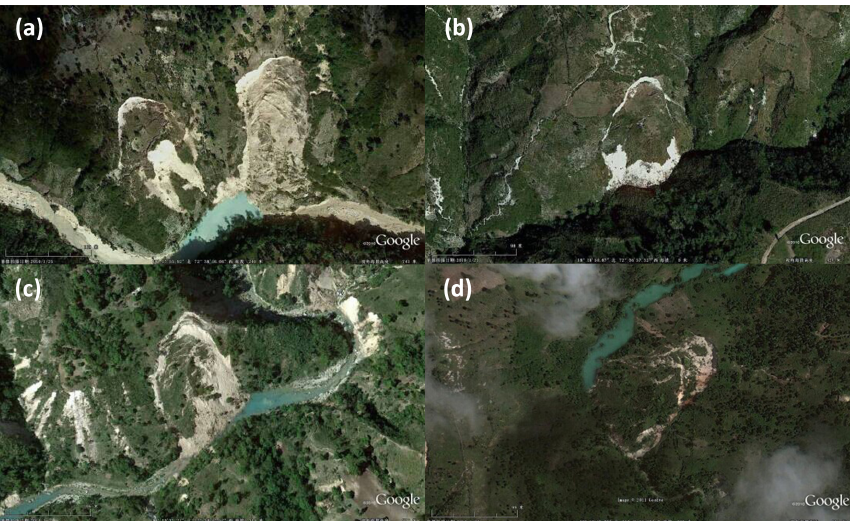
Figure 6. Several typical co-seismic coherent deep-seated landslides. (a) two coherent deep-seated landslides (18 ◦ 17 0 54.15 00 N, 72 ◦ 38 0 18.95 00 W) within a short distance; the image is taken on 25 January 2010 (upward is north). (b) is located at 18 ◦ 18 0 50.87 00 N, 72 ◦ 36 0 57.32 00 W, and the image was taken on 25 January 2010 (upward is north). (c) is located at 18 ◦ 19 0 37.21 00 N, 72 ◦ 39 0 47.57 00 W; the im- age is taken on 25 January 2010 (upward is west). (d) is located at 18 ◦ 12 0 17.83 00 N, 72 ◦ 43 0 35.27 00 W and the image is taken on 27 June 2010 (upward is